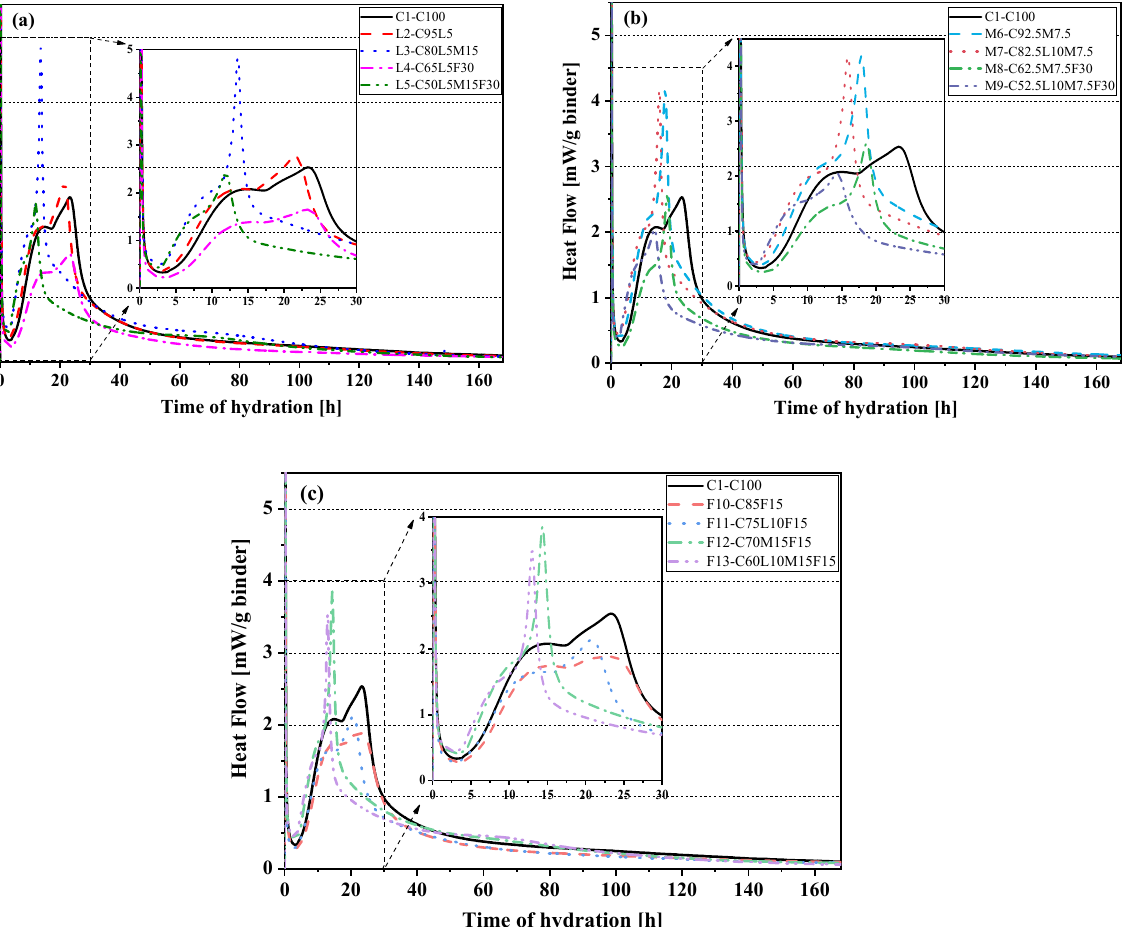
Figure 3. Rates of hydration heat: ( a ) the control specimen and LS system; ( b ) the control specimen and MK system; ( c ) the control specimen and FA system.